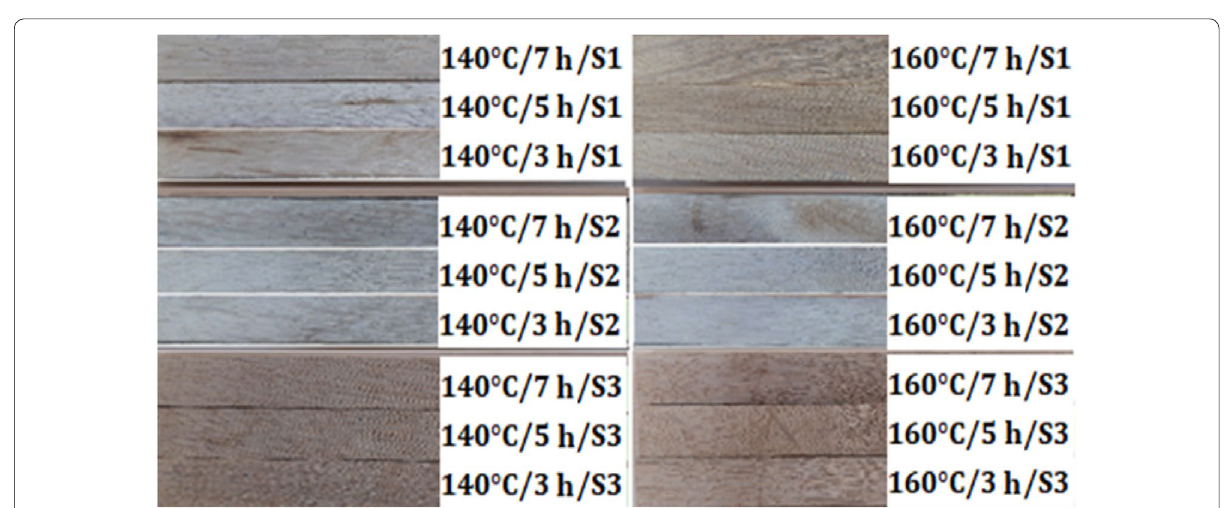
Fig. 9 Heat-treated oak samples after bleaching